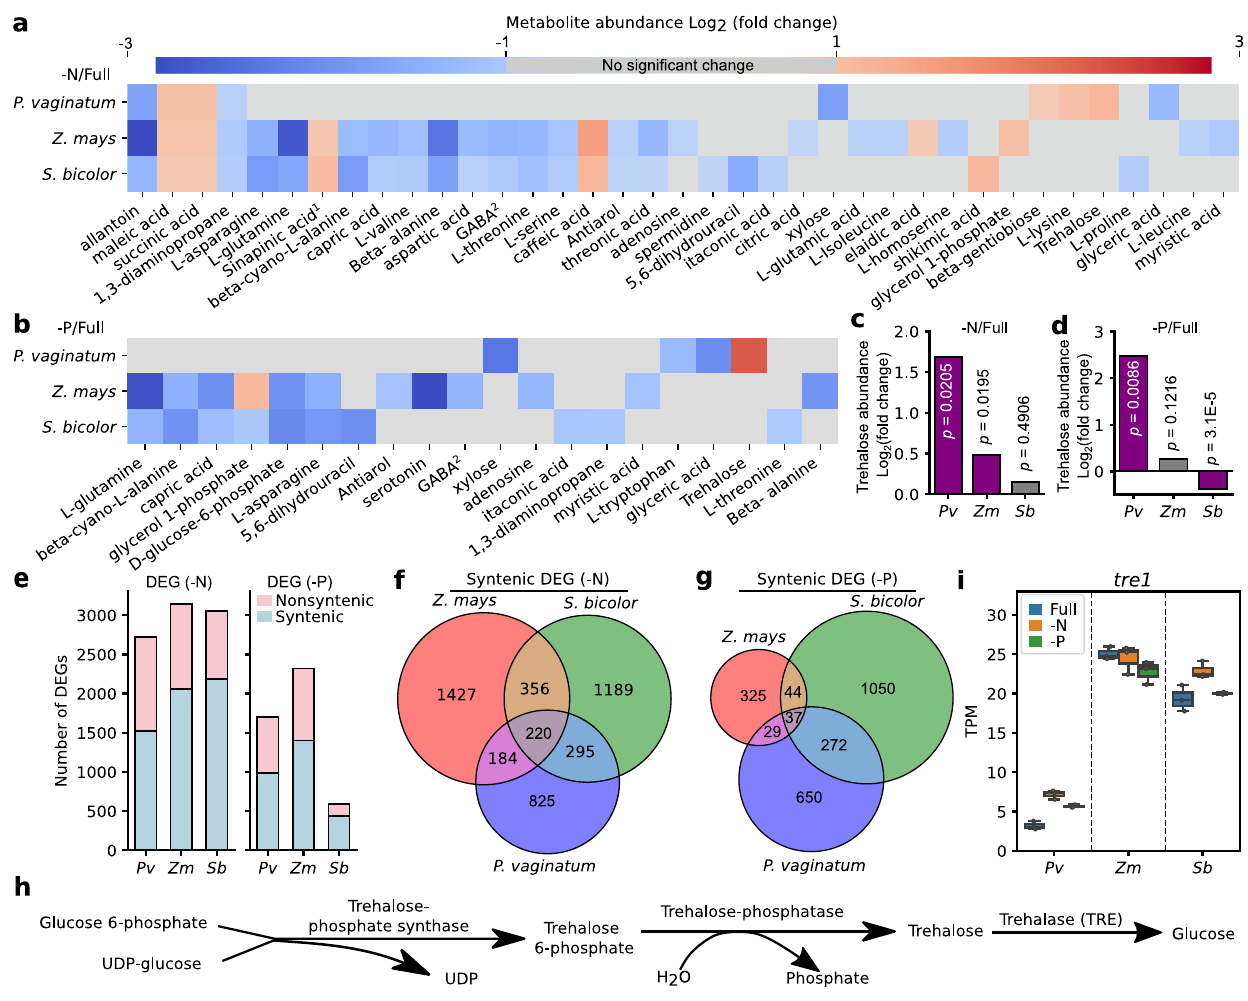
Fig. 3 | Primary metabolic and transcriptomic responses of three studied to nutrient-de fi cit stress. a , b Changes in the abundance of metabolites in the roots of paspalum ( Pv ), maize ( Zm ) and sorghum ( Sb ) under -N conditions ( a ) and -P condition ( b ) at 21 dap relative to plants grown under Full condition. Only the metabolites with a statistically signi fi cance change in abundance ( p <0.05; t -test; two t ailed) and an absolute fold change >2 in at least one of the three species evaluated are shown. Raw data and exact p-values are included in Supplementary Data 4. c , d Change intrehalose abundanceintheroots of 3-week-oldplants under -N ( c ) and -P ( d ) conditions relative to control plants. Signi fi cant changes are de fi ned as p values ( t -test; two tailed) lower than 0.05 and log 2 fold change higher than1andareindicatedinpurple,andnon-signi fi cantchangesareindicatedingray. For a – d : N =5 independent biological replicates consisting of pooled tissue from